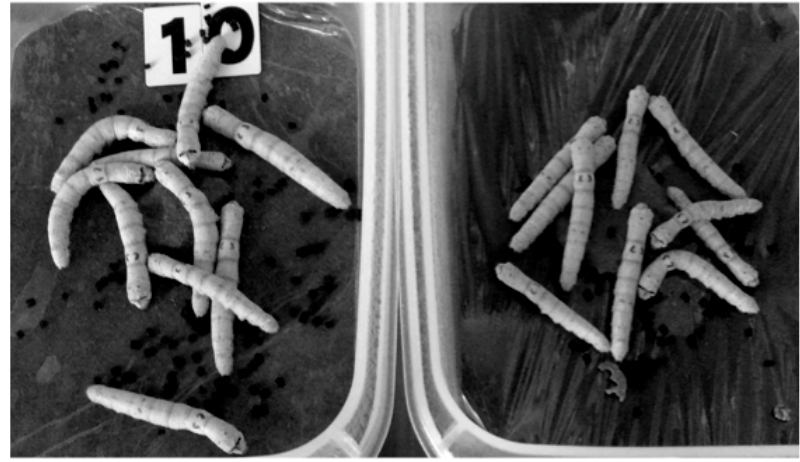
Figure 2. Photograph of silkworms on day 44 after the start of the experiment. Left: Radiation-emitting sheet group; right: Control group.